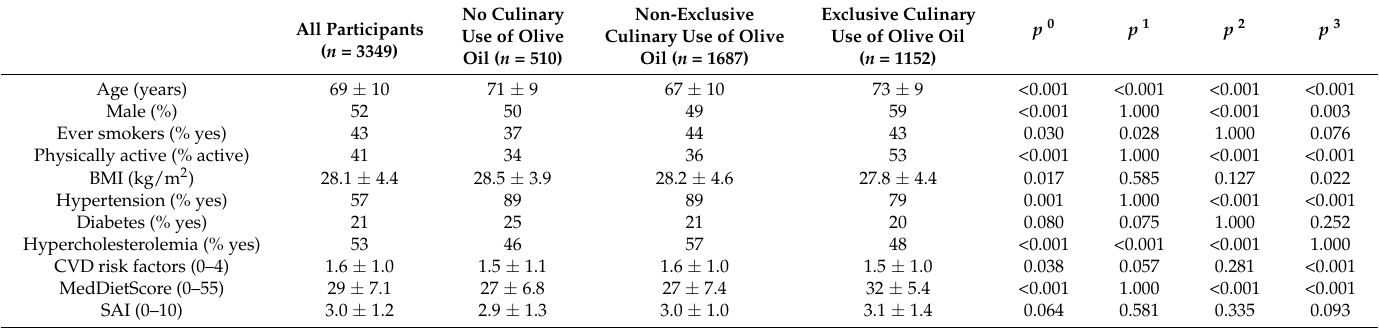
Table 1. Socio-demographic, lifestyle, and clinical characteristics of the participants based on All and the category type of dietary fat consumption.